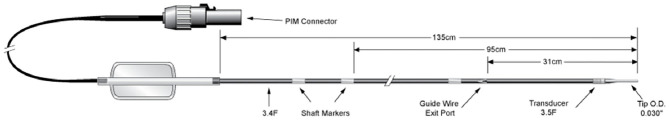
Commonly used peripheral vascular intravascular ultrasound catheter. It comes on a 0.014- or 0.035-inch guidewire with monorail system.